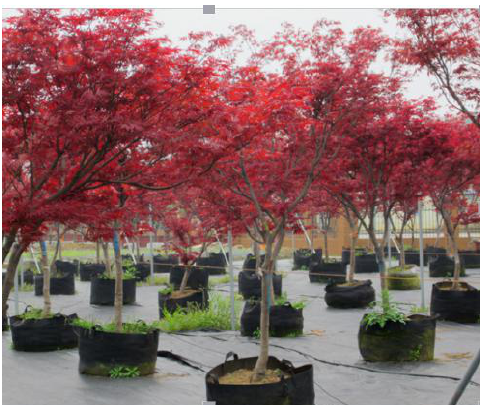
Fig. A3.3: Rural income and vitality: facilitating agricultural development